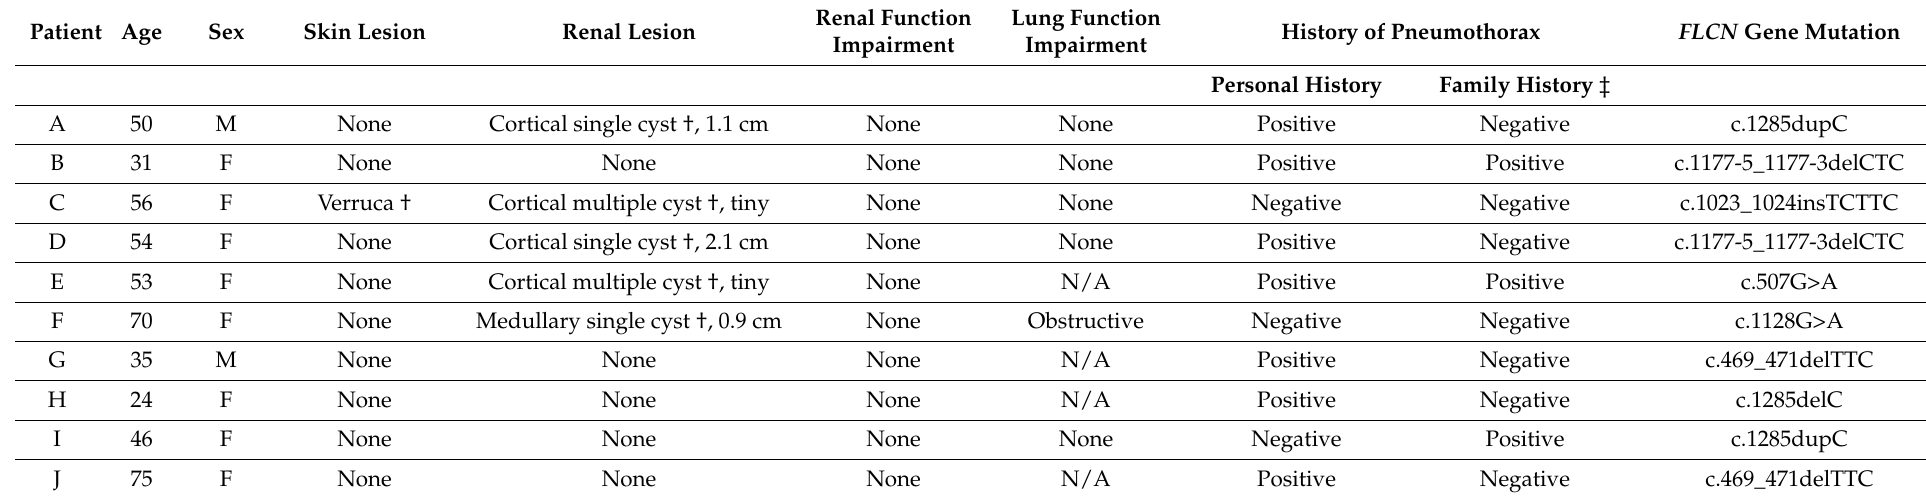
Table 2. Clinical and FLCN gene characteristics of BHD